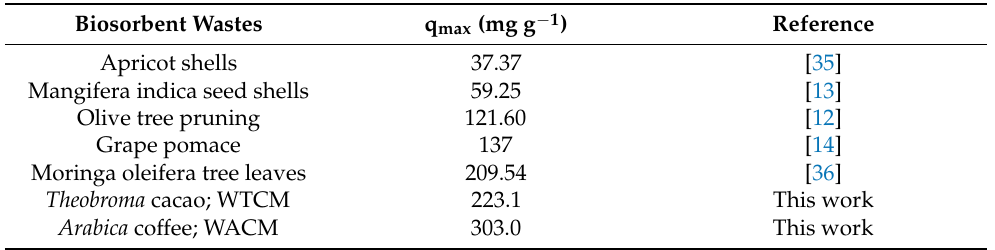
Table 3. Comparative table of the maximum adsorption capacity q max of Pb(II), for biosorbents with alkaline treatment.